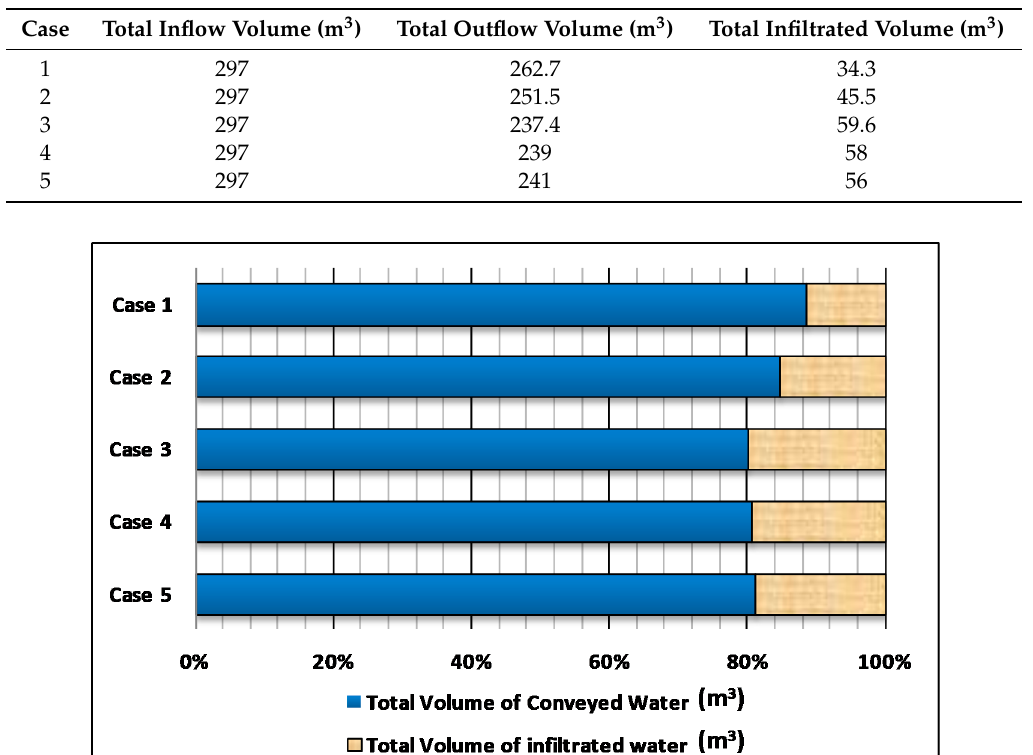
Figure 12. The percentage of the total volume of conveyed and infiltrated water. Table 4. The total inflow, outflow, and infiltration volumes after 90 min.